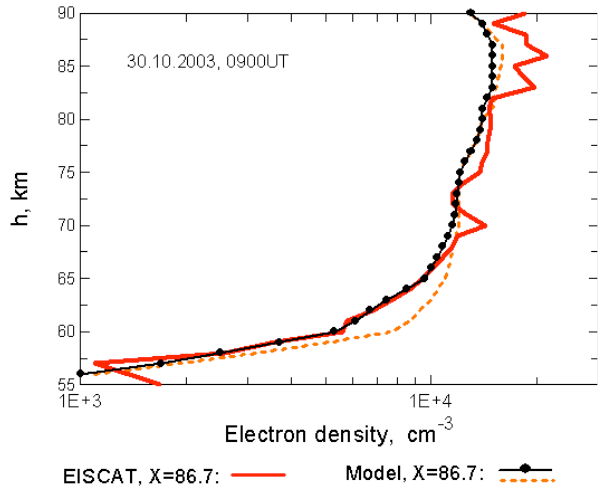
Fig. 6b. electron density profiles measured by EISCAT radar (red curve) and calculated for the SPE on 30 October 2003 at 09:00UT for zenith angle 86.7 ◦ (black curve) using the O, O 3 and NO pro- files 4–6 in Fig. 1. Red dashed curve using the O, O 3 and NO profiles 1–3 in Fig.